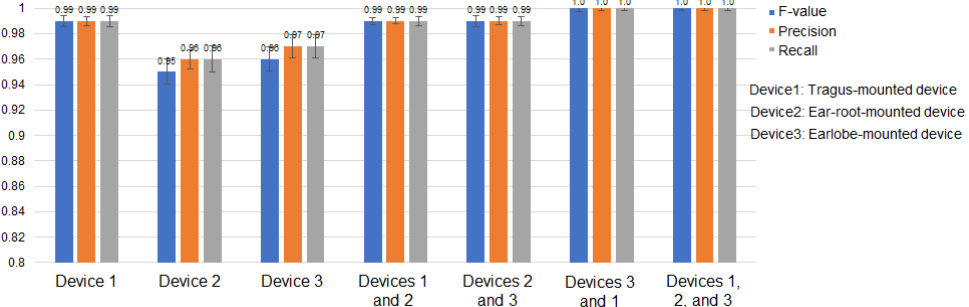
Figure 9. The results of Evaluation 1 using nine gestures. The average F-value for each device pattern. Device 1 is a tragus-mounted device, Device 2 is an ear-root-mounted device, and Device 3 is an earlobe-mounted device. Device combinations are classified into seven types (i.e., individual use and a combination of each